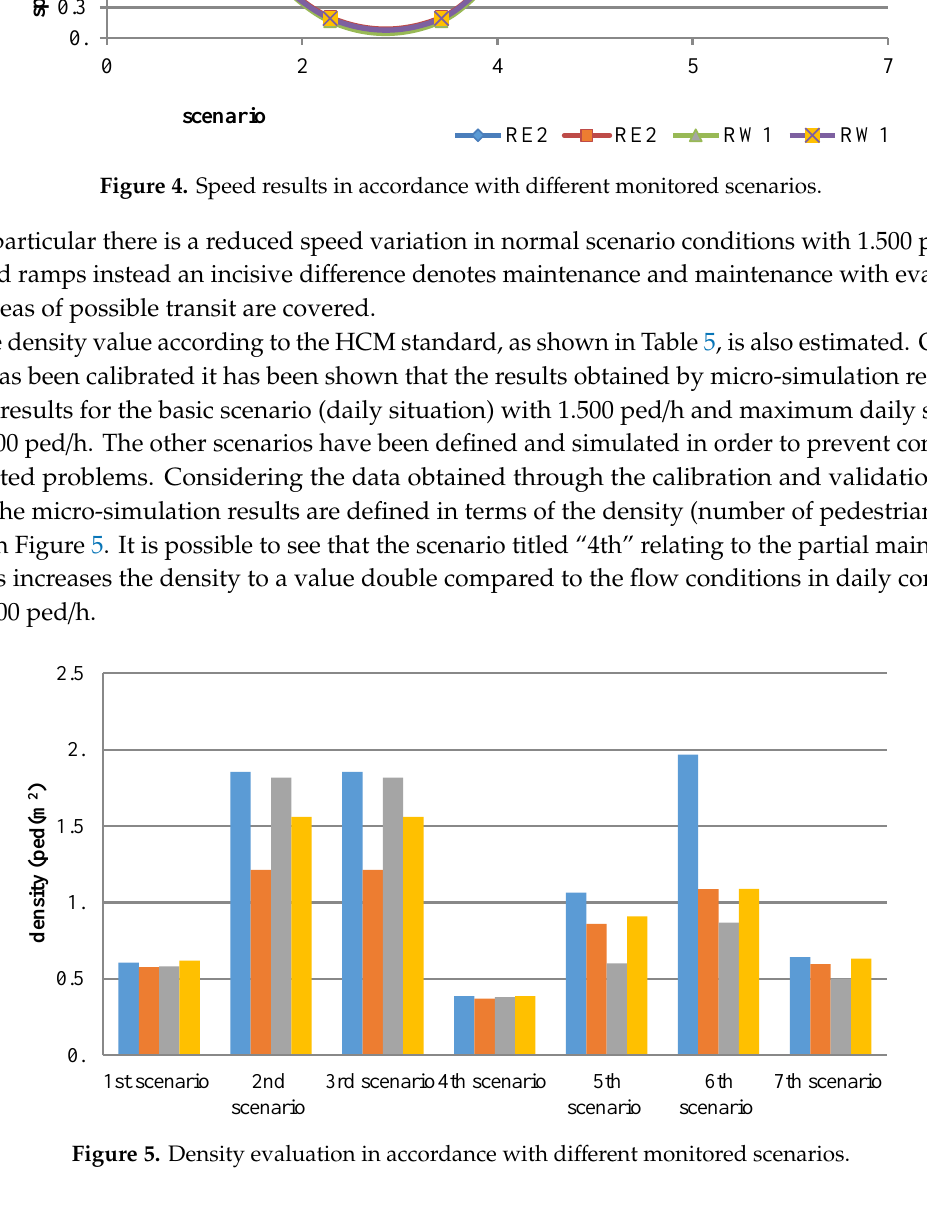
Table 7. LOS values in accordance with Fruin model.